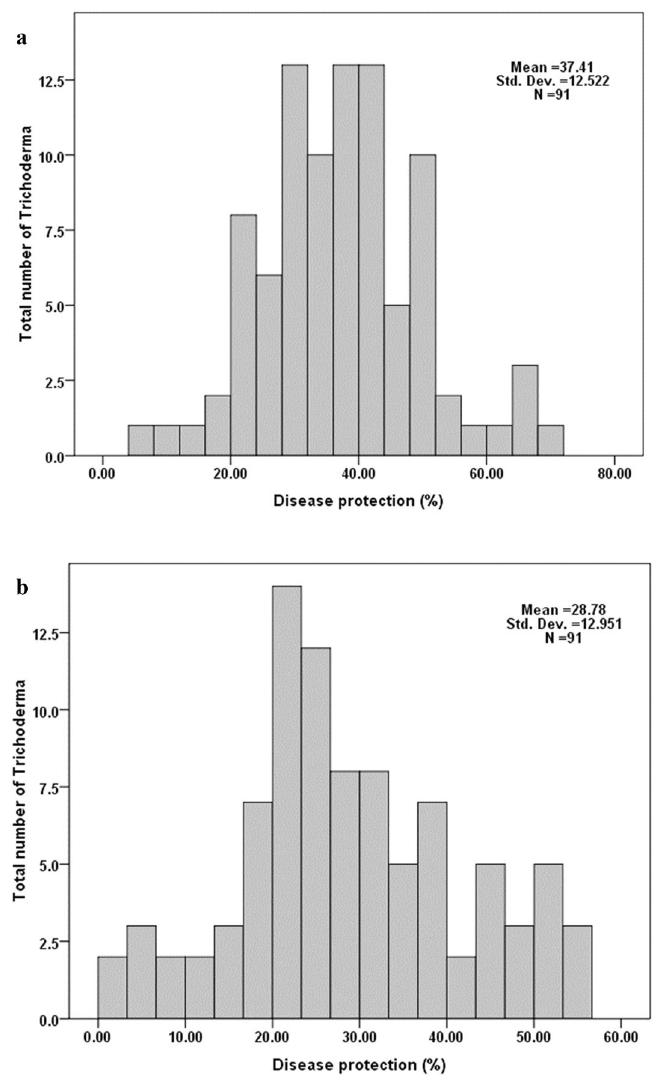
Figure 7. Histogram representing distribution of disease protection pattern among Trichoderma when employed as seed treatment. ( a ) Pathogen inoculated as soil amendment and ( b ) Pathogen inoculated as soil amendment followed by whorl